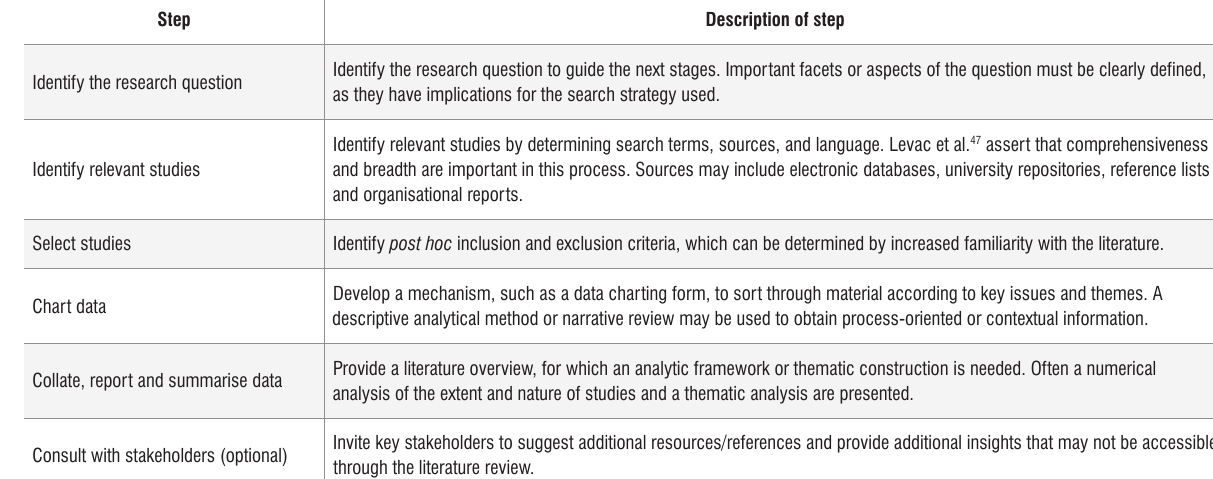
Arksey and O’Malley’s 49 five-stage